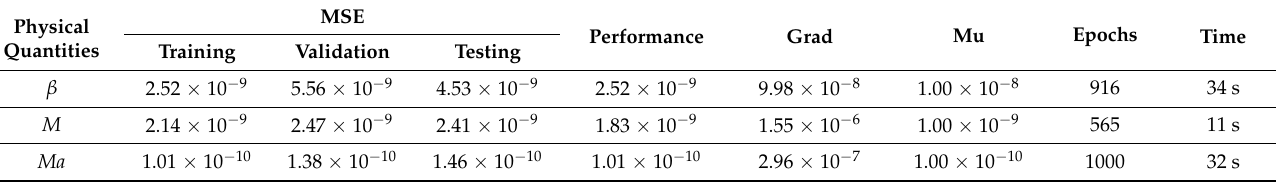
Figure 3. The Flow Architecture for MHD-SGFM.